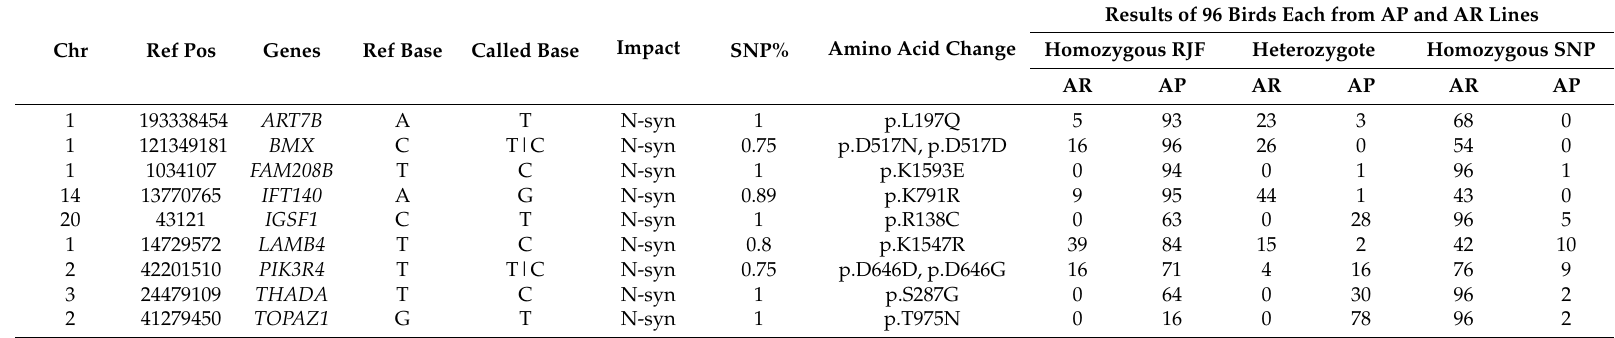
Table 4. Validation of SNPs using allele-specific PCR in 96 AR and 96 AP line chickens.